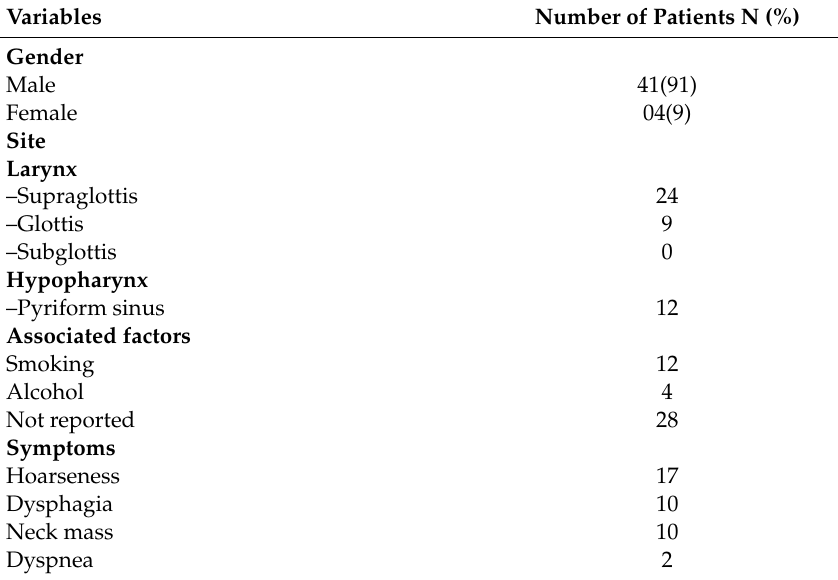
Table 1. Patient